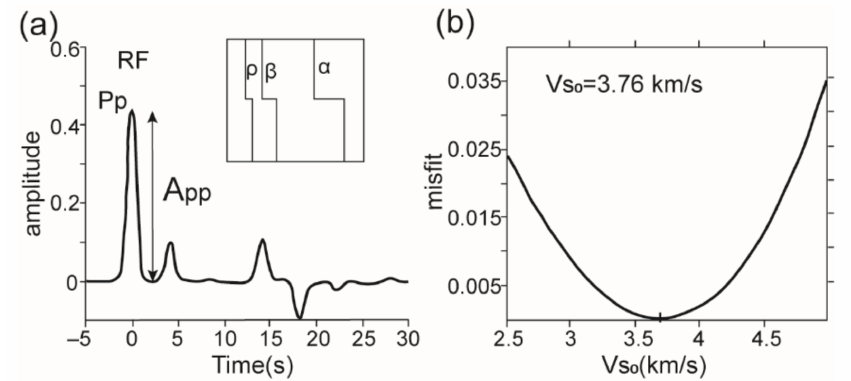
Figure 2. Receiver function of a single epicentral distance ( a ) and the subsurface SWV ( b